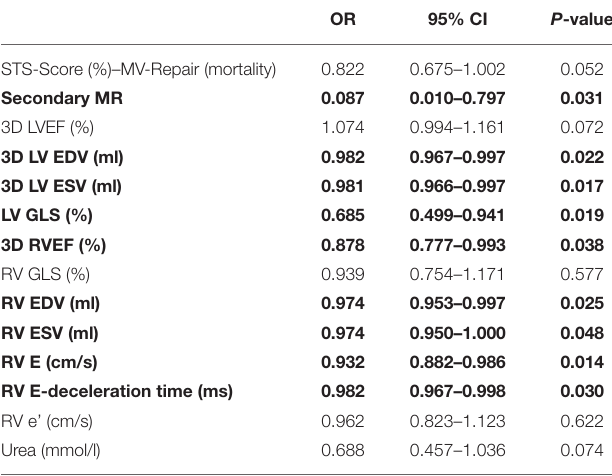
TABLE 4 | Predictors of improvement of right ventricular function after percutaneous mitral valve repair (PMVR) in the subgroup of patients with reduced RV function (RVEF ≤ 45%) at baseline ( n = 36) in univariable